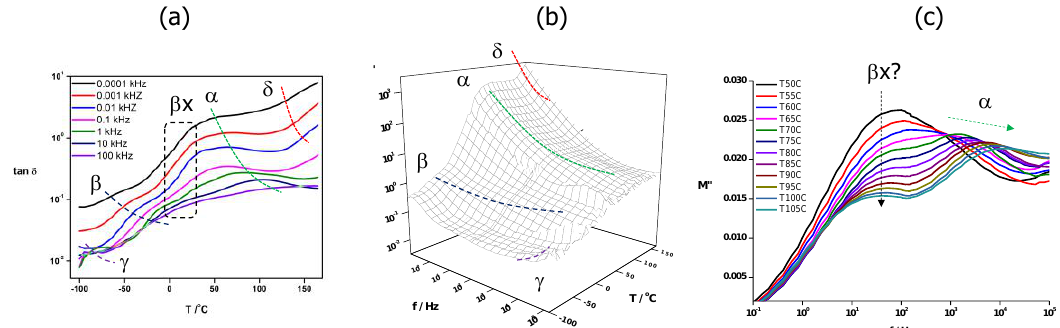
Figure 10. Dielectric response of PA-b-PS-b-PM, highlighting the δ -, α -, β -and γ - relaxations: ( a ) temperature dependence of tan δ = ε′′ / ε′ at selected frequencies; ( b ) 3D plot of the temperature and frequency dependence of the loss factor ε′′ ; ( c ) imaginary component of the electric modulus, M’’, as a function of the frequency, obtained at different temperatures. The appearance of a sub-glass β x process is also highlighted in the plots.